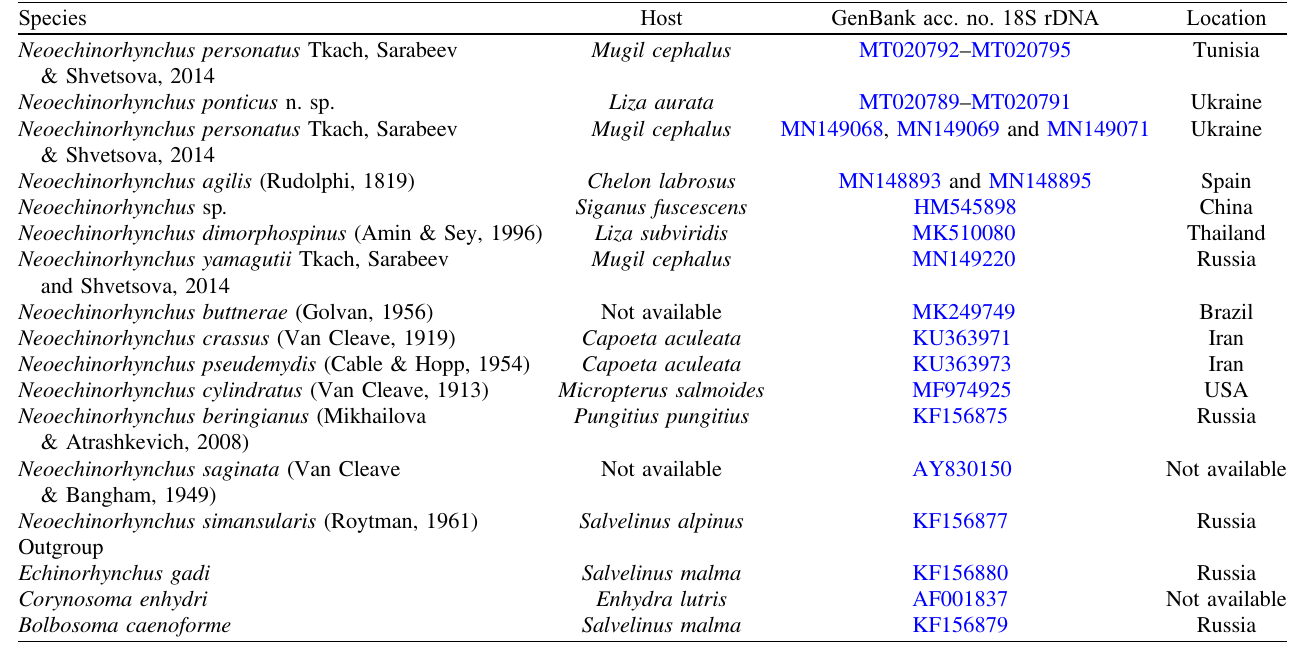
Table 1. Acanthocephalan species represented in the phylogenetic analysis with their host species, GenBank accession numbers, and locations.